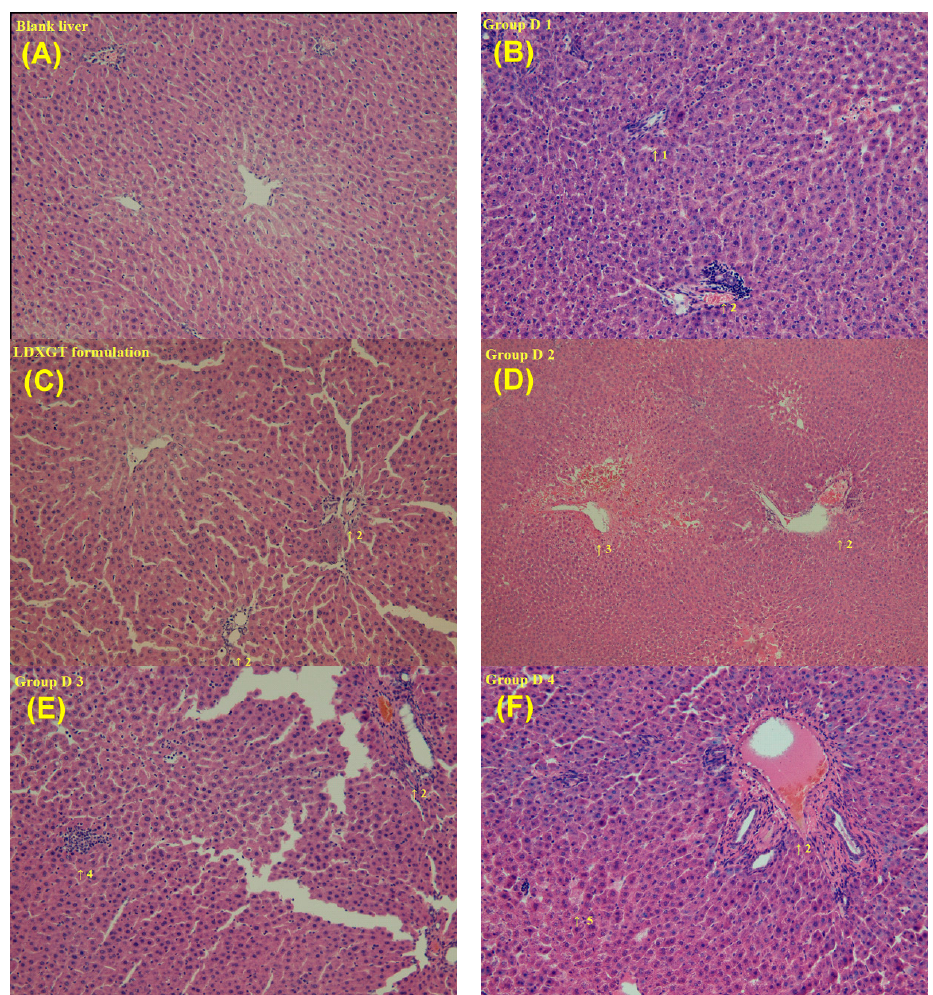
Figure 4. Histopathological analyses of the rat livers from groups administered a single dose of drug. ( A ) Blank liver: normal liver; ( B ) Group D1: sorafenib (3 mg/kg, i.v.); ( C ) LDXGT formulation: